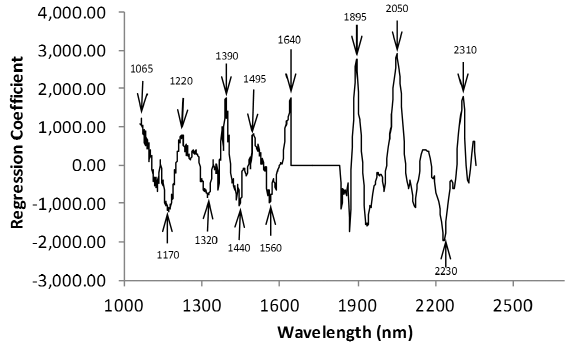
Fig. 8. Regression coe±cient plot of brown Hommali